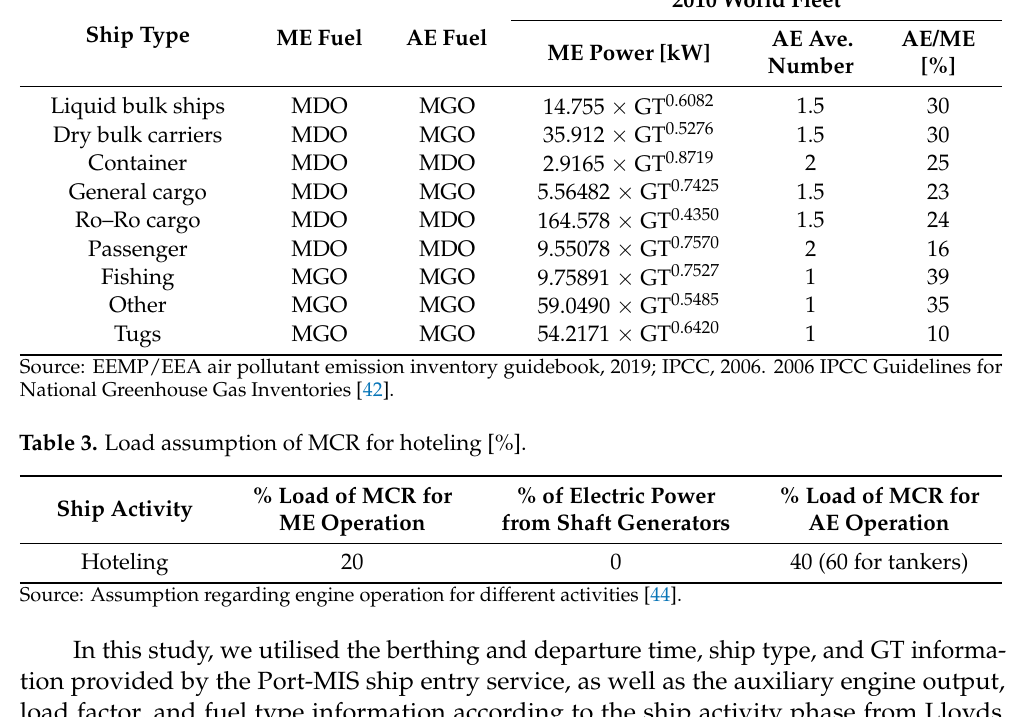
Table 2. Installed main engine power as a function of the gross tonnage (GT), vessel ratio of the auxiliary engine (AE) to the main engine (ME), and fuel type by ship type.